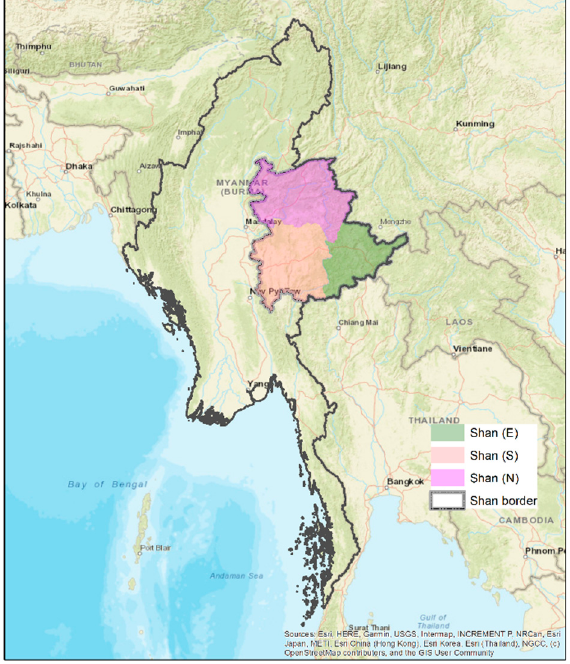
Figure 1. Shan State, Myanmar, and neighboring countries